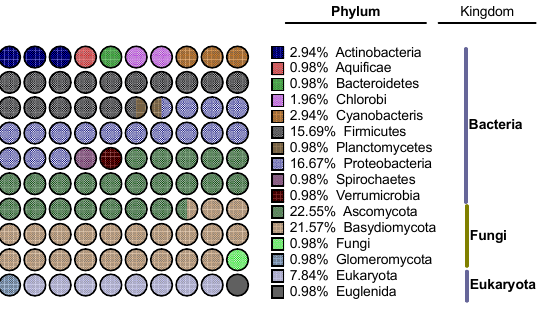
Figure 9. E ff ect of filifolinone on OTU abundance. The figure shows the distribution among kingdom and phyla of OTUs with statistically significant di ff erences in the abundance between filifolinone-treated fish and untreated fish. A total of 102 OTUs showed di ff erences in abundance ( p < 0.05), most of these being from the Kingdoms Bacteria and Fungi. Statistical significance was determined by a t -test with p < 0.05.